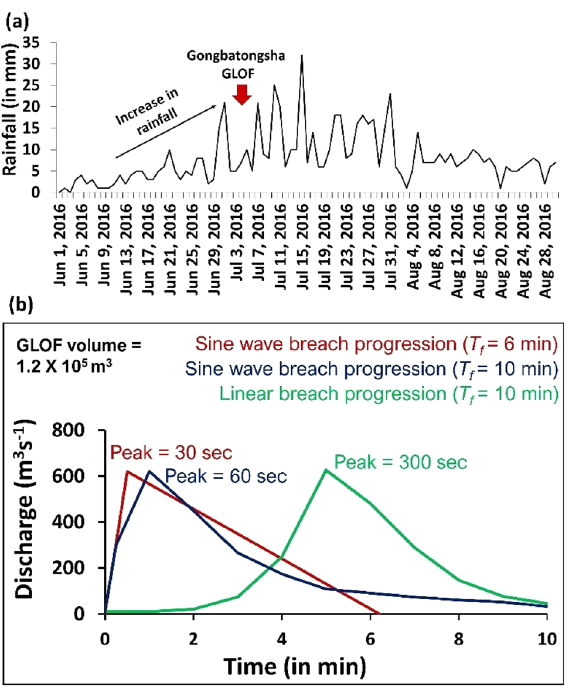
Figure 4. ( a ) Trend of precipitation from June to August 2016; red arrow marks the date of the Gongbatongsha GLOF event; ( b ) Reconstructed GLOF hydrographs of the Gongbatongsha Lake for different lake breach